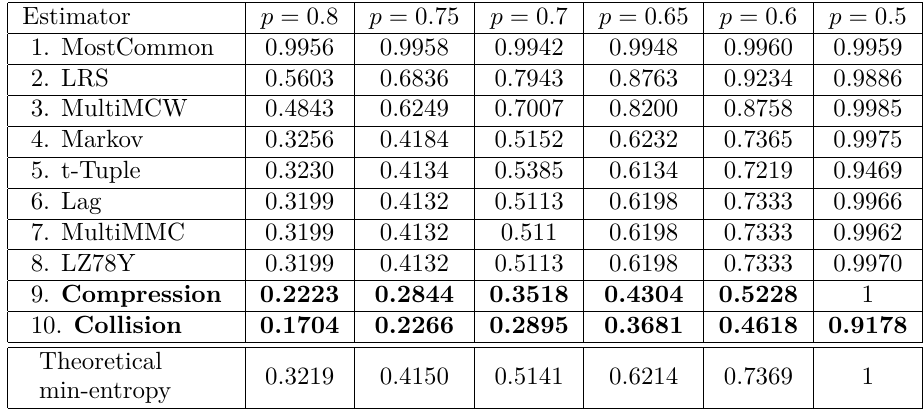
Table 2: Entropy estimates for first-order Markov process with different p ’s Estimator